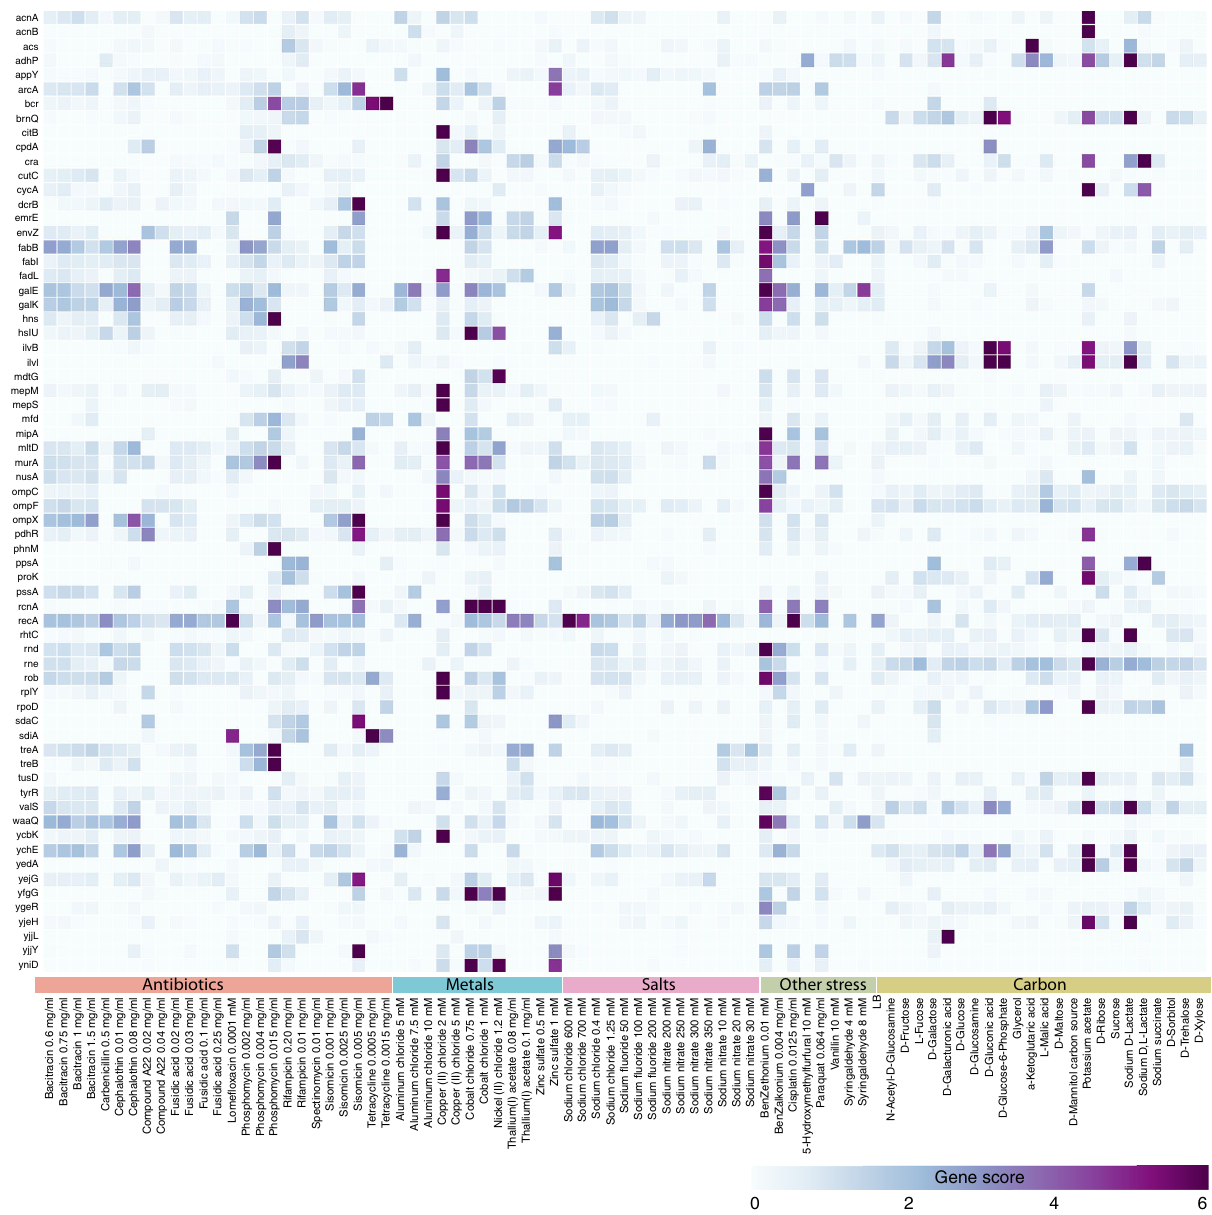
Fig. 4 Heatmap of dual-barcoded shotgun expression library sequencing (Dub-seq) fi tness data for 52 conditions and for 67 genes with large bene fi ts. Only genes with a high-con fi dence effect and gene fi tness score > = 6 in at least one condition are shown. Gene scores from two replicate experiments were averaged. Source data are provided as a Source Data fi